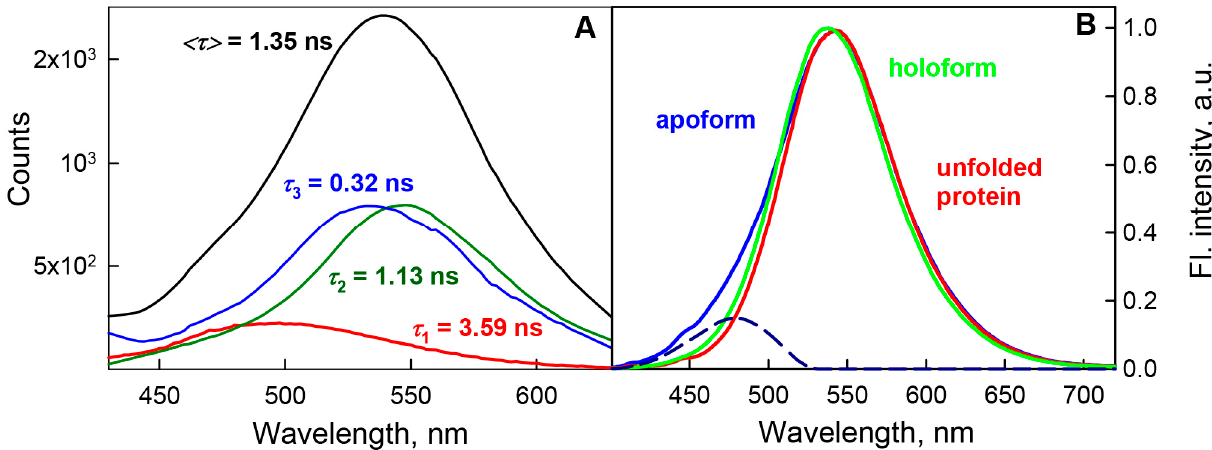
Figure 4. Decomposition of the fluorescence spectrum of BADAN linked to the GGBP/H152C apoform. Panel ( A ) Decay- associated spectrum of BADAN linked to GGBP/H152C apoform after global analysis of 100 dye decay curves recorded from 430 to 630 nm with step 2 nm. Colors indicate spectra associated with the particular decay time. Excitation wavelength was 372 nm. Panel ( B ) Decomposition of the fluorescence spectrum of BADAN linked to the GGBP/H152C apoform into components based on the analysis of the characteristics of the dye attached to various structural states of GGBP/H152C. The fluorescence spectra of BADAN attached to GGBP/H152C in the apoform, the holoform, and the unfolded state are shown in blue, green, and red solid curves, respectively. The spectra are normalized to the fluorescence intensity at their maximum. The short-wavelength component of BADAN fluorescence obtained by subtracting the fluorescence spectrum of the dye attached to denatured GGBP/H152C from the spectrum of the dye attached to the native apoprotein is shown by the blue dashed curve. Excitation wavelength was 387 nm.